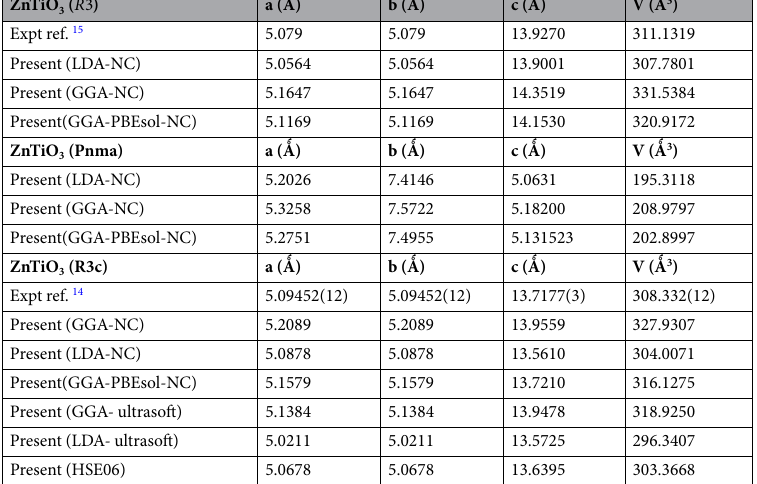
Table 1. The calculated Lattice constants and volumes of the ilmenite (IL)-type (space group R 3 ) and Perovskite (Pv)-type (space group Pnma) and LiNbO 3 -type (space group R3c) ZnTiO 3 based on norm-conserving (NC), ultrasoft pseudopotentials and Heyd-Scuseria-Ernzerhof screened hybrid functional (HSE06).